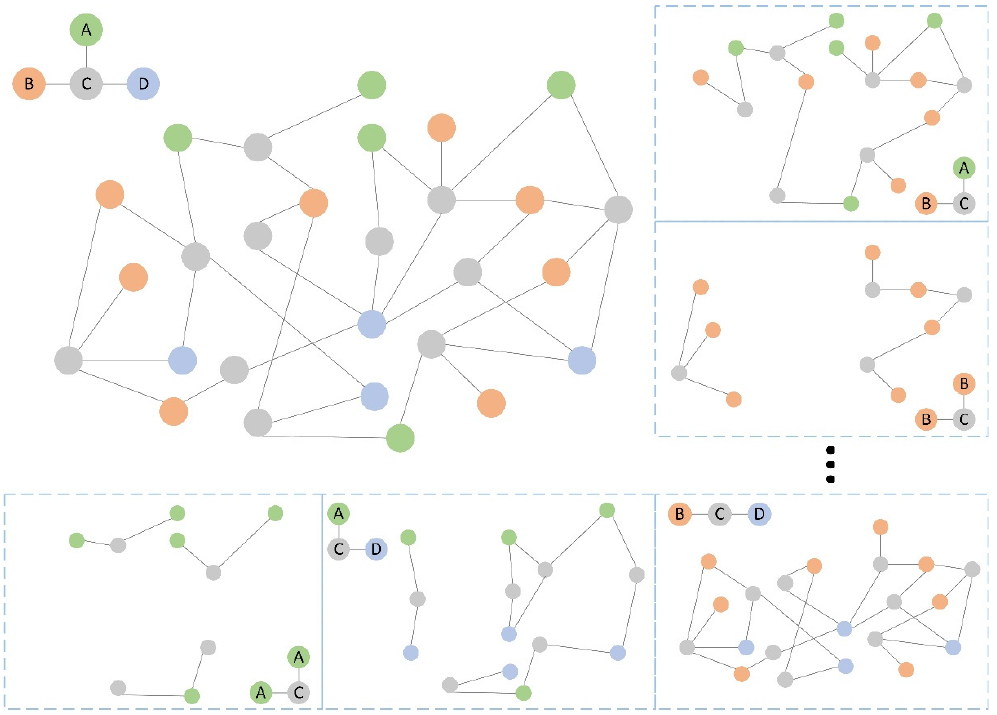
Figure 2. Illustration of a heterogeneous graph for four different node types and their corresponding motif subgraphs.